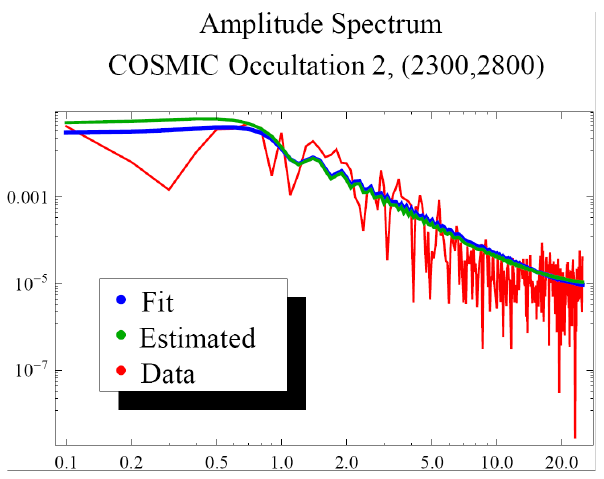
Fig. 23. Amplitude frequency spectrum (in Hz) for occultation 2 (red), model spectrum using estimated parameters (green), and “by- eye” fitted parameters (blue).